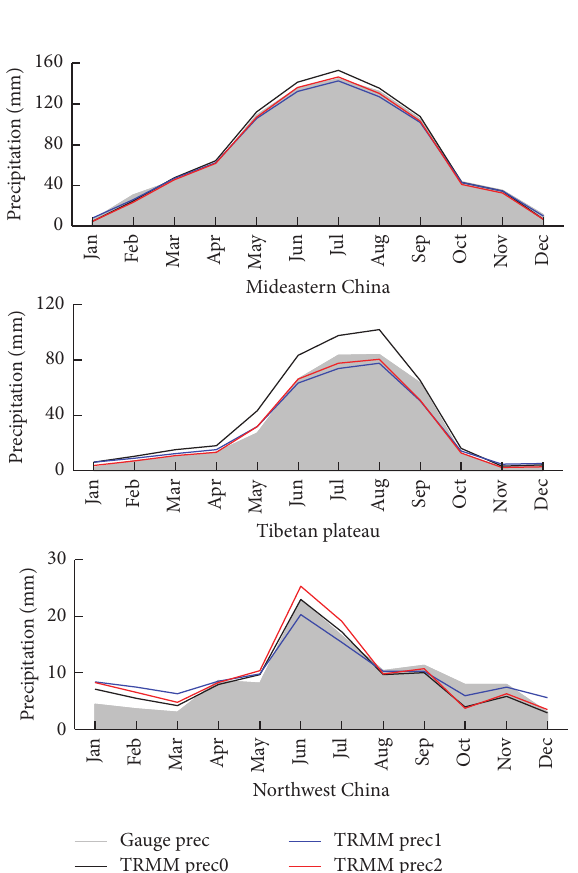
Figure 9: Average monthly gauge precipitation and original/cor- rected TRMM precipitation in the three regions in